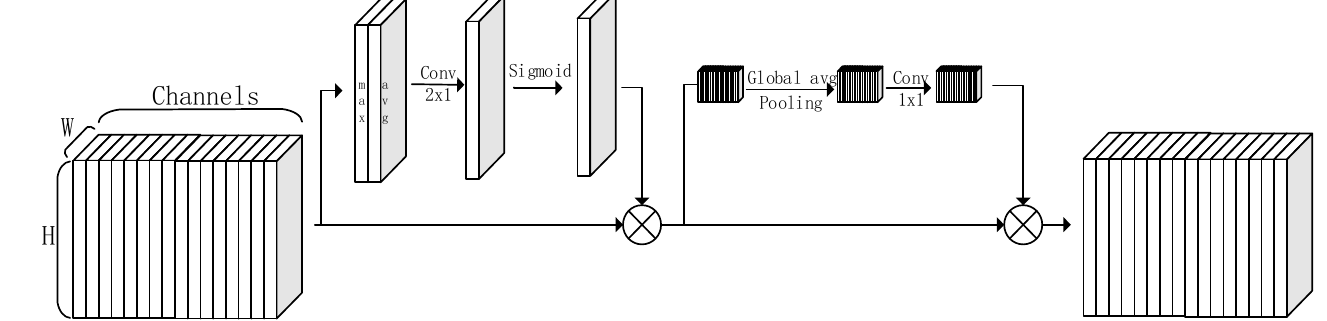
Figure 11. Schematic diagram of the attention module used in this study.